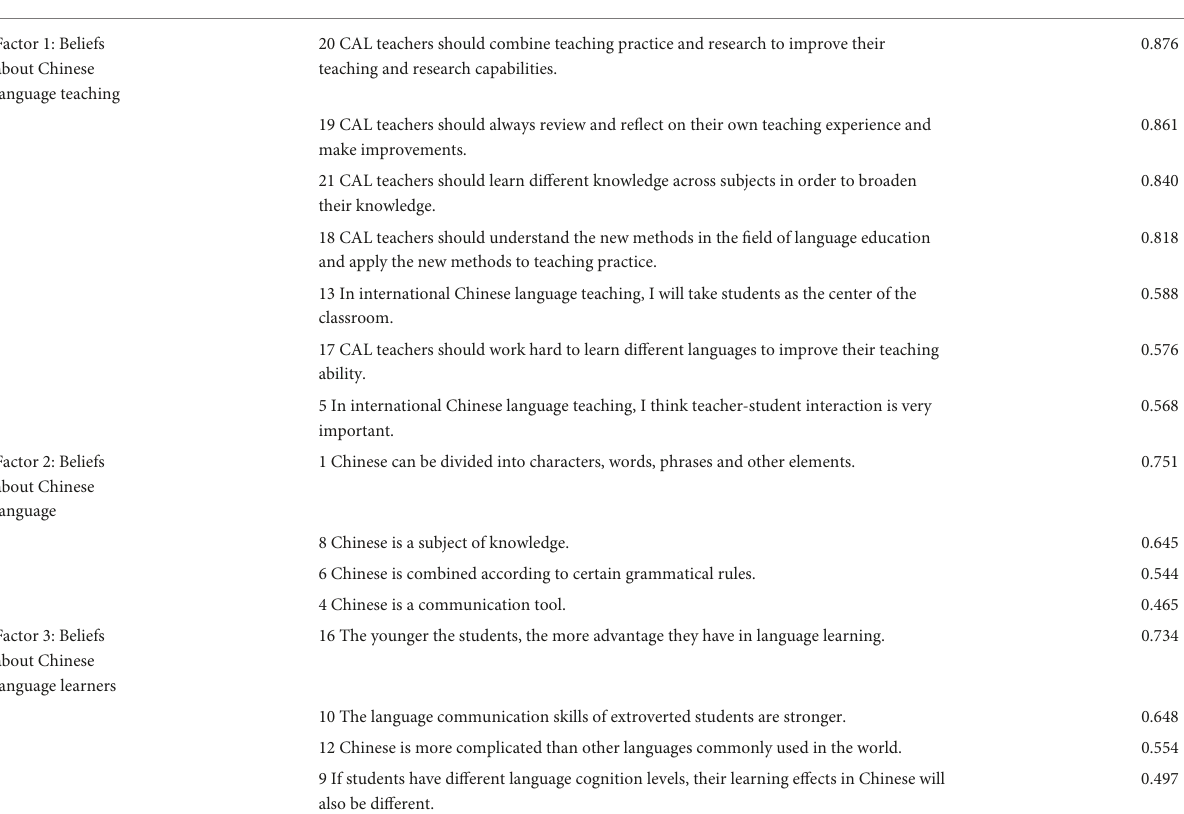
TABLE 6 Result of exploratory factor